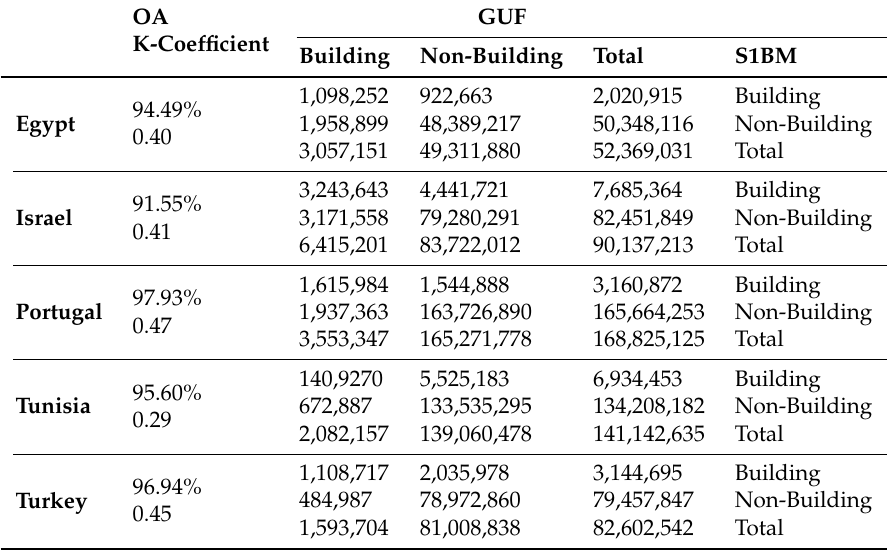
Table 1. Quantitative analysis and confusion matrices for the five different test cases. S1BM & GUF